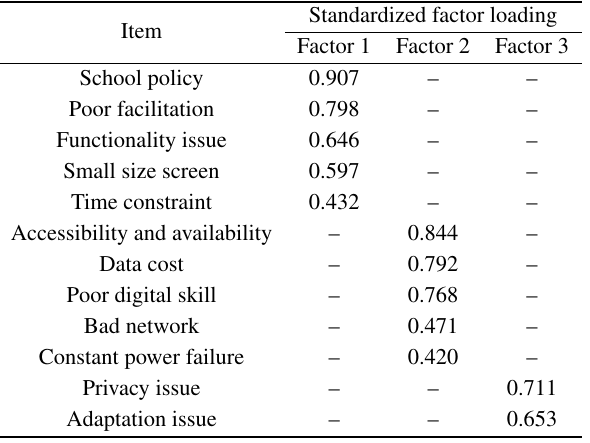
Table 9 Standardized factor loadings from the exploratory factor analysis on